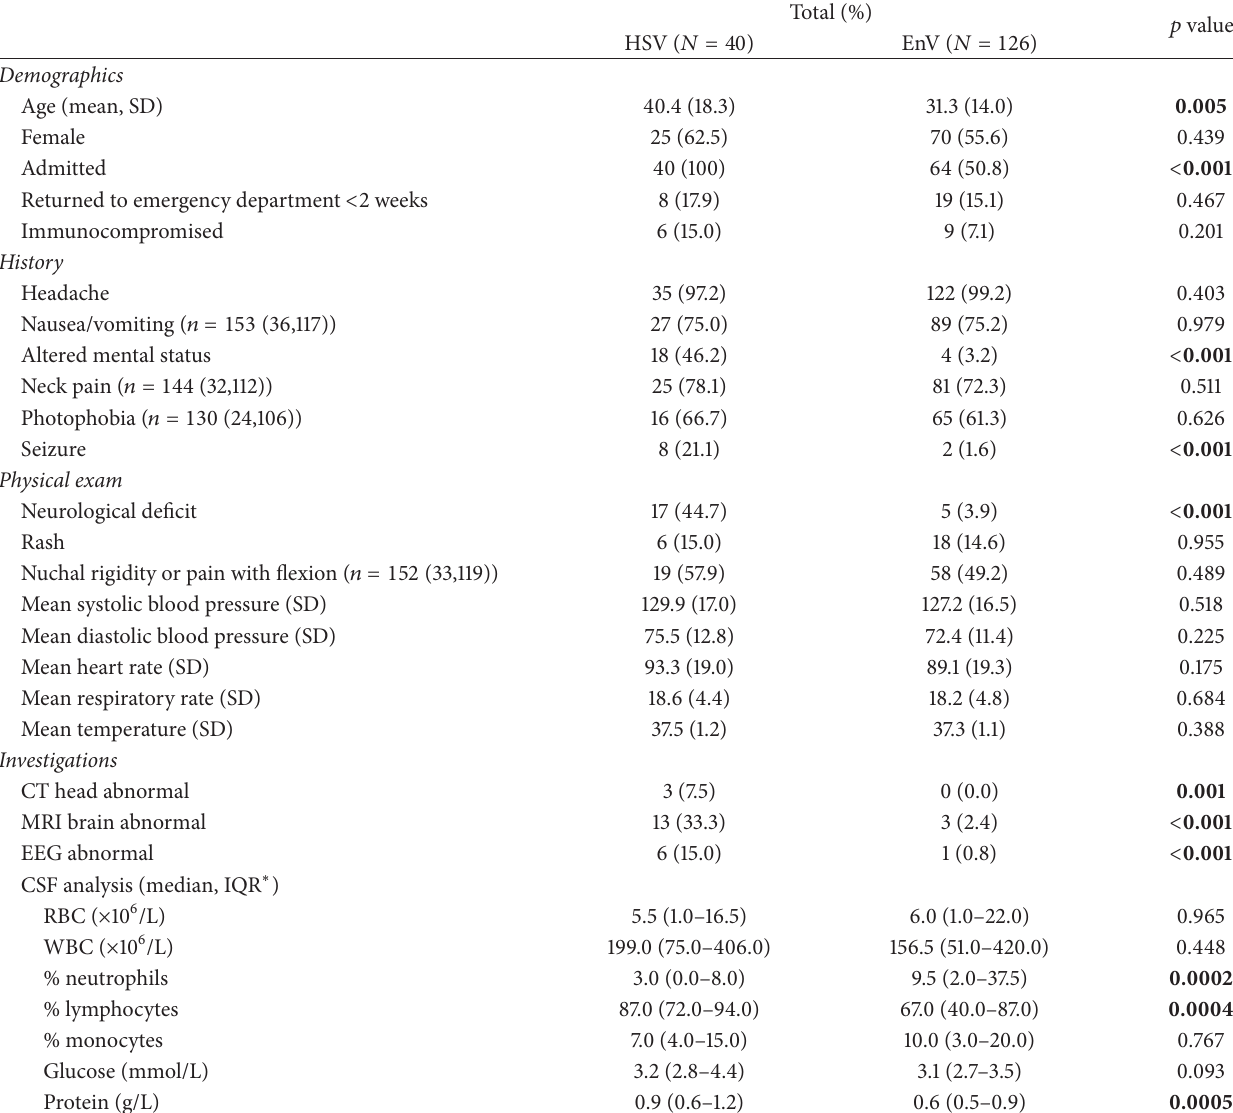
Table 2: Comparison of demographic and clinical characteristics and investigations between patients with HSV and EnV ( 𝑁 = 166